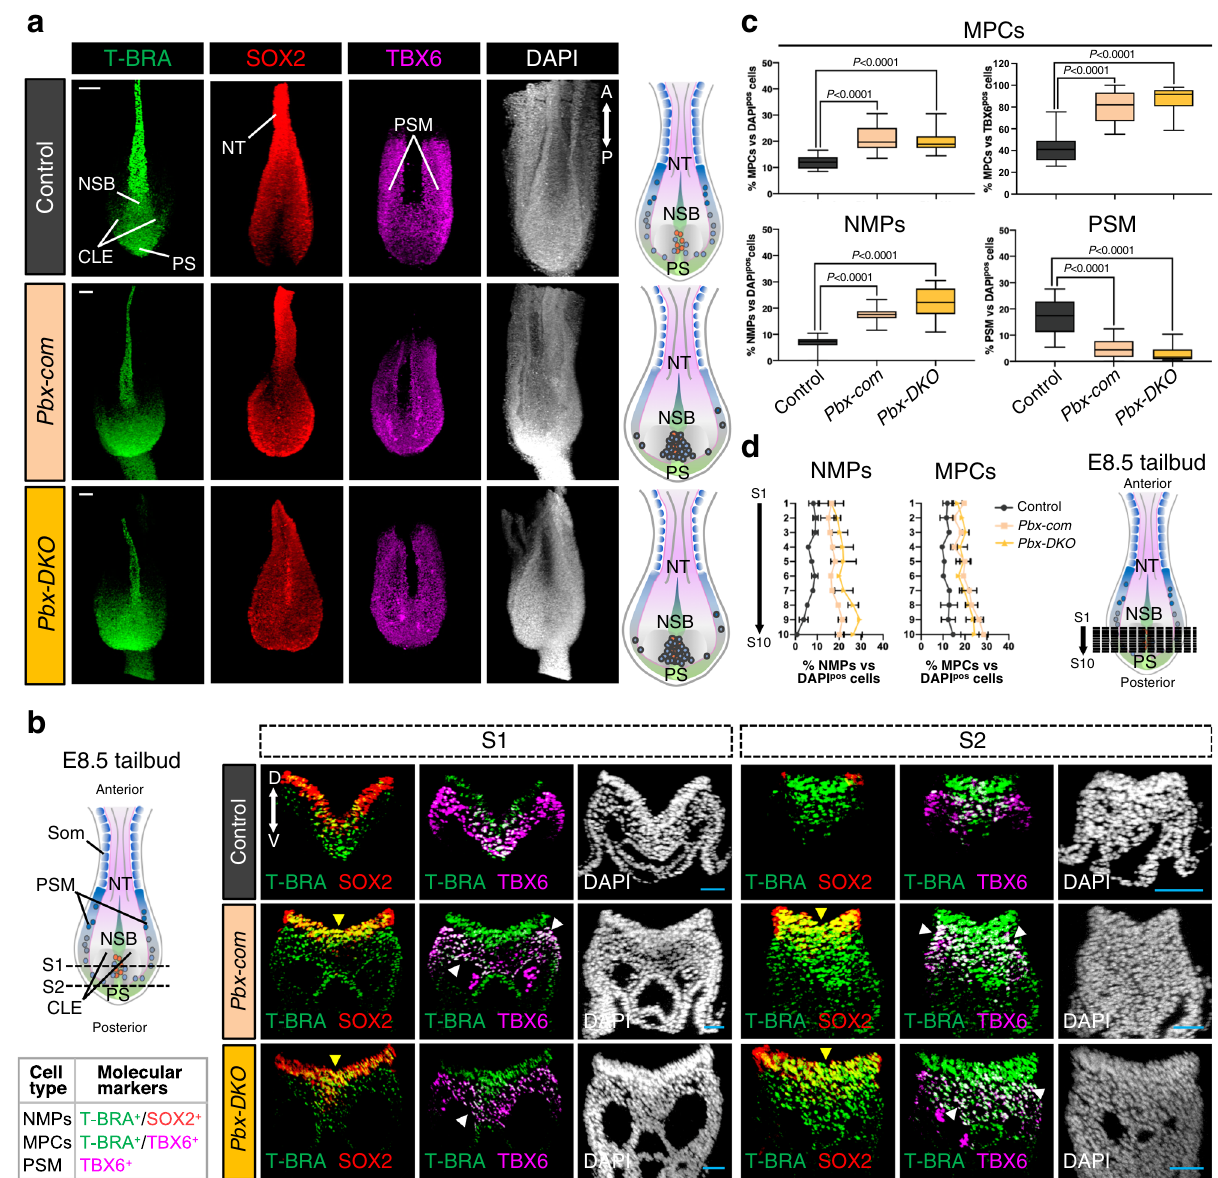
Fig. 2 Pbx mutant NMPs fail to acquire paraxial mesodermal fate, do not progress towards PSM, and accumulate in the tailbuds. a Confocal maximum intensity projection images of E8.5 tailbuds probed with T-BRA (green), SOX2 (red) and TBX6 (magenta) antibodies and counterstained with DAPI (grey) reveal the enlarged CLE and accumulation of T-BRA pos , SOX2 pos , TBX6 pos cells in Pbx-com and Pbx-DKO tailbuds. The cartoons on the right depict dorsal views of E8.5 control and Pbx mutant tailbuds, with NMPs represented as red dots and MPCs as blue dots. Scale bars: 50 µ m. b Confocal transverse sections of control, Pbx-com and Pbx-DKO tailbuds through the caudal progenitor zone. Black dashed lines in the cartoon indicate the plane of sections. Representative sections S1 and S2 reveal accumulation of T-BRA/SOX2 double-positive (T-BRA pos ;SOX2 pos ) NMPs in Pbx mutants (yellow arrowheads). TBX6 staining shows reduced expression in PSM and co-localisation with NMP markers in Pbx-com and Pbx-DKO tailbuds (white arrowheads). The panel on the left summarises the molecular signature used to identify the different cell types along the path towards PSM. Scale bars: 30 µ m. c Box plots assessing the proportion of T-BRA pos ;TBX6 pos cells (MPCs) relative to DAPI pos cells (total cells) or to TBX6 pos cells (PSM), and T-BRA pos ;SOX2 pos cells (NMPs) and TBX6 pos cells (PSM) relative to DAPI pos cells. The box contains the 25th to 75th percentiles of the dataset, the centre line denotes the median value (50th percentile) and the whiskers extend from the smallest to the largest value. P -values were calculated by one-way ANOVA and Tukey ’ s test for multiple comparisons and are indicated in the fi gure. d Distribution of NMPs and MPCs along the anterior/posterior axis shows accumulation of NMPs and MPCs in the posterior tailbud of Pbx-com and Pbx-DKO embryos. Data are mean ± s.e.m. Black dashed lines in the cartoon indicate the plane of sections. In c and d , the percentage of different cell types for each embryo was calculated from 10 independent sections equally distributed along the anterior/posterior axis. In a , b and d : CLE caudal lateral epiblast, NSB node-streak border, PS primitive streak, PSM pre-somitic mesoderm, Som somites, NT neural tube, A anterior, P posterior, D dorsal, V